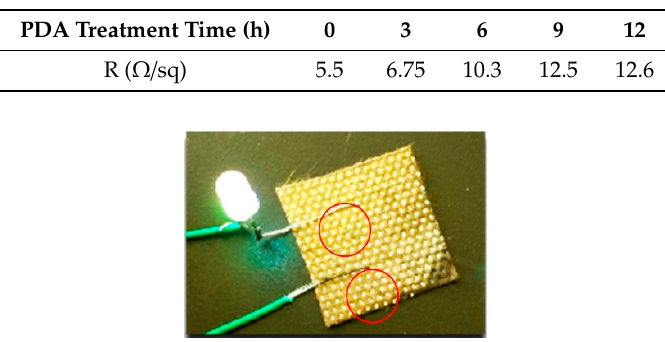
Figure 6. The mapping dots and elements’ weights of the dopamine-treated Ag-coated fabric.